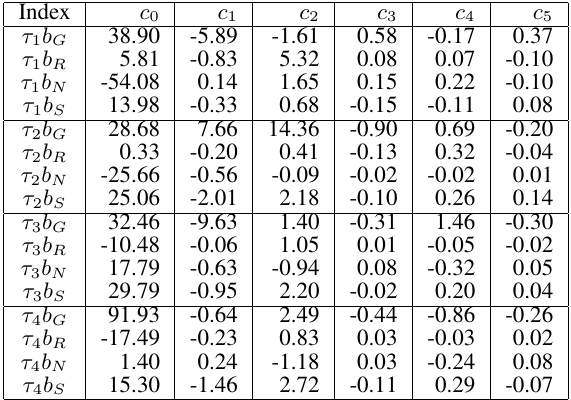
Table 3. Parameters ( × 10 − 3 ) of the spatial offset model, τ for period index and b for band